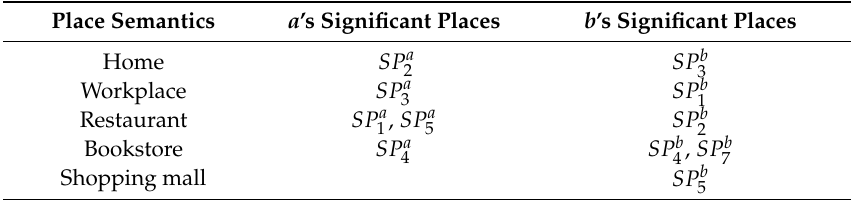
Table 1. An example of grouping the significant places of two individuals, a and b